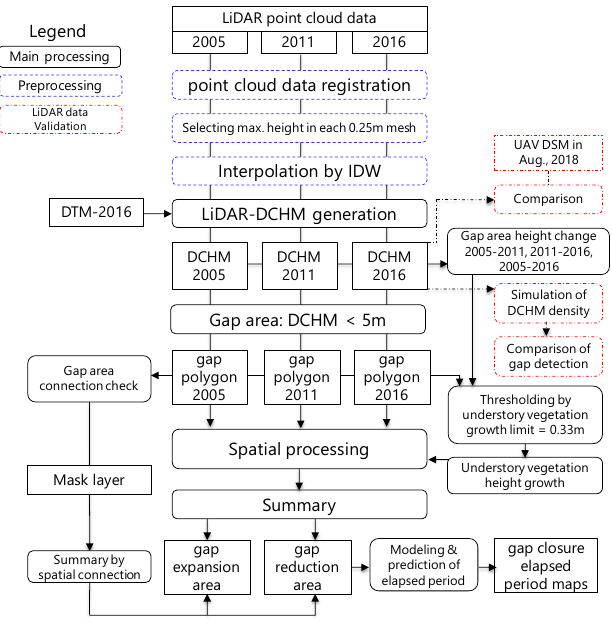
Figure 2. Analysis flow.